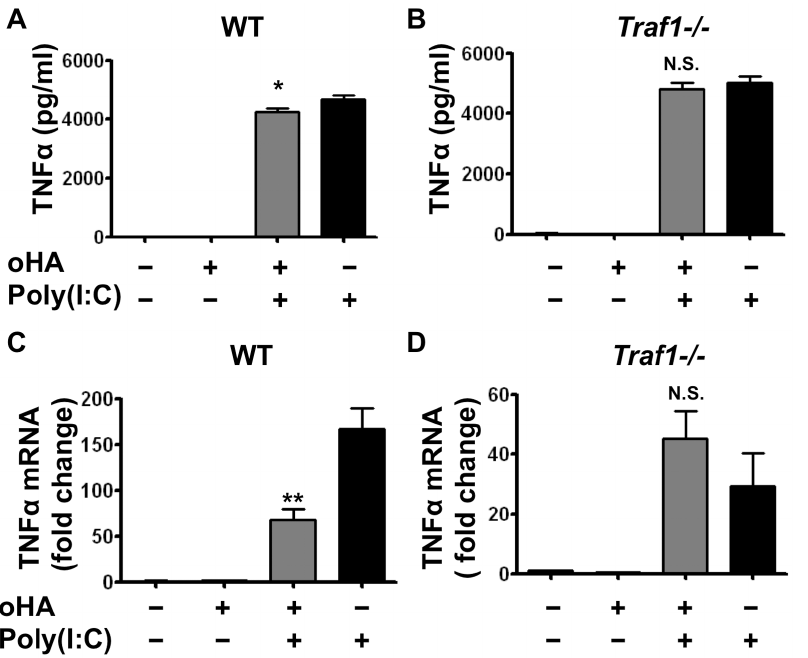
Figure 6. TRAF1 is necessary for oligo-HA to suppress TNF a secretion and mRNA expression in peritoneal macrophages. Peritoneal macrophages from WT (A, C) and Traf1 2 / 2 mice (B, D) were treated with oligo-HA and/or poly(I:C) for 24 h. TNF a release in cultured media was measured by ELISA (A, B). mRNA abundance for TNF a was assessed by quantitative RT-PCR 4 h after treatment (C, D). Quantitative RT-PCR data are presented as normalized data against vehicle-treated macrophages. Data are presented as means 6 S.E.M. and are representative of three independent experiments with n=3. *: p , 0.05. **: p , 0.01, N.S.: not significant.